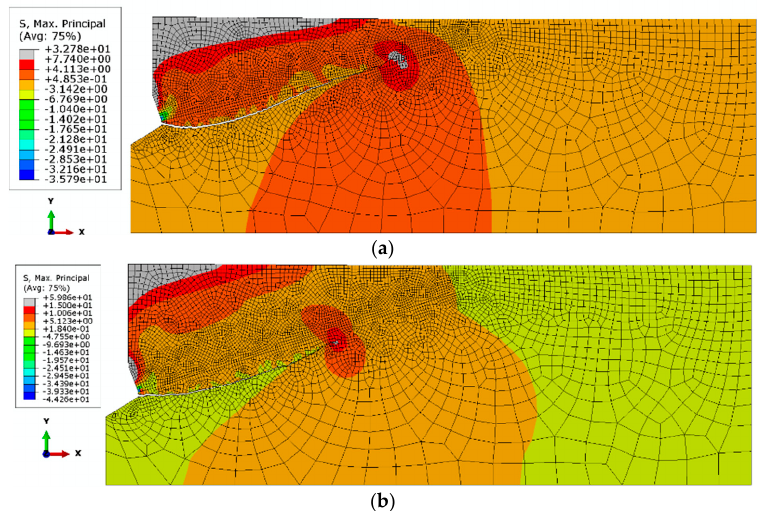
Figure 11. The course of the trajectory of failure in the initial stage of material fracture, for various variants of tensile strength f t : ( a ) f tI = 7.74 MPa, ( b ) f tII = 15 MPa.